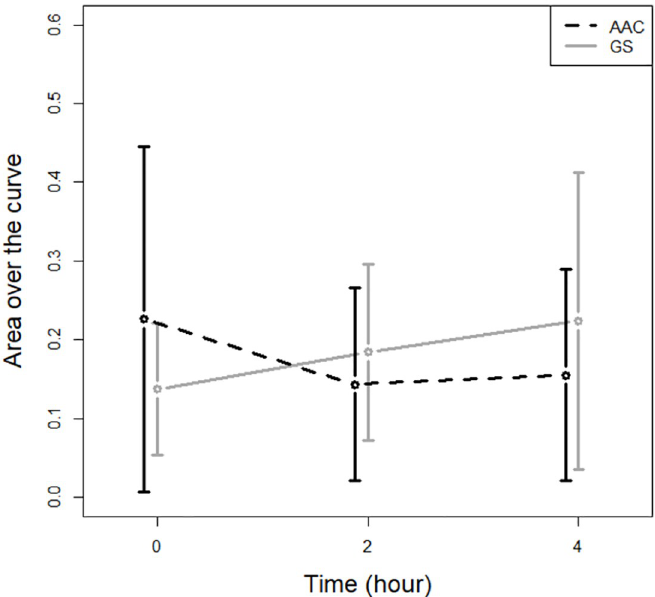
Fig 3. The late post-illumination pupillary response during the two experimental days. The late post-illumination pupillary response before, 2, and 4 hours after either amino acid challenge (AAC) or equicaloric glucose solution (GS).